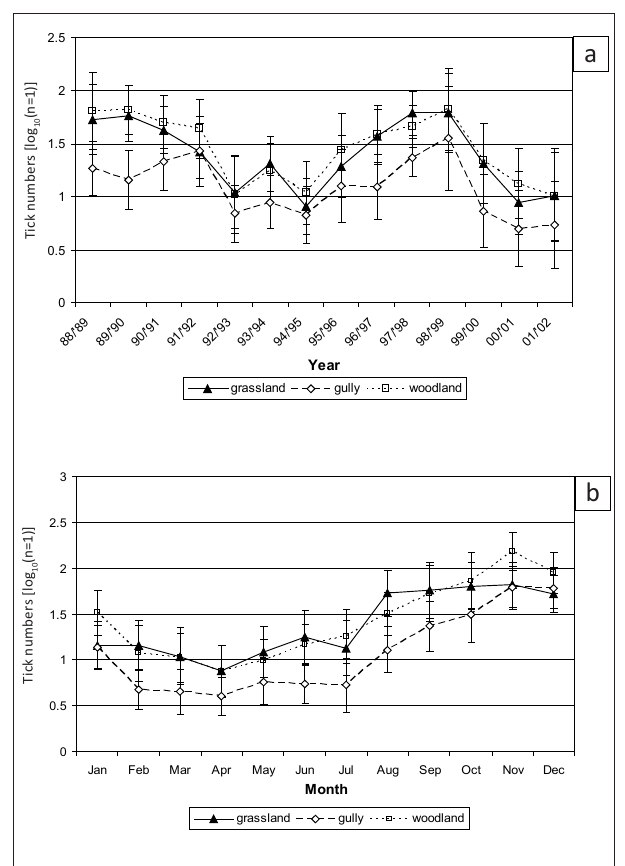
FIGURE 5: Mean (± 95% confidence interval) collections of Rhipicephalus decoloratus larvae by a) year and b) month for each habitat at Nhlowa Road and